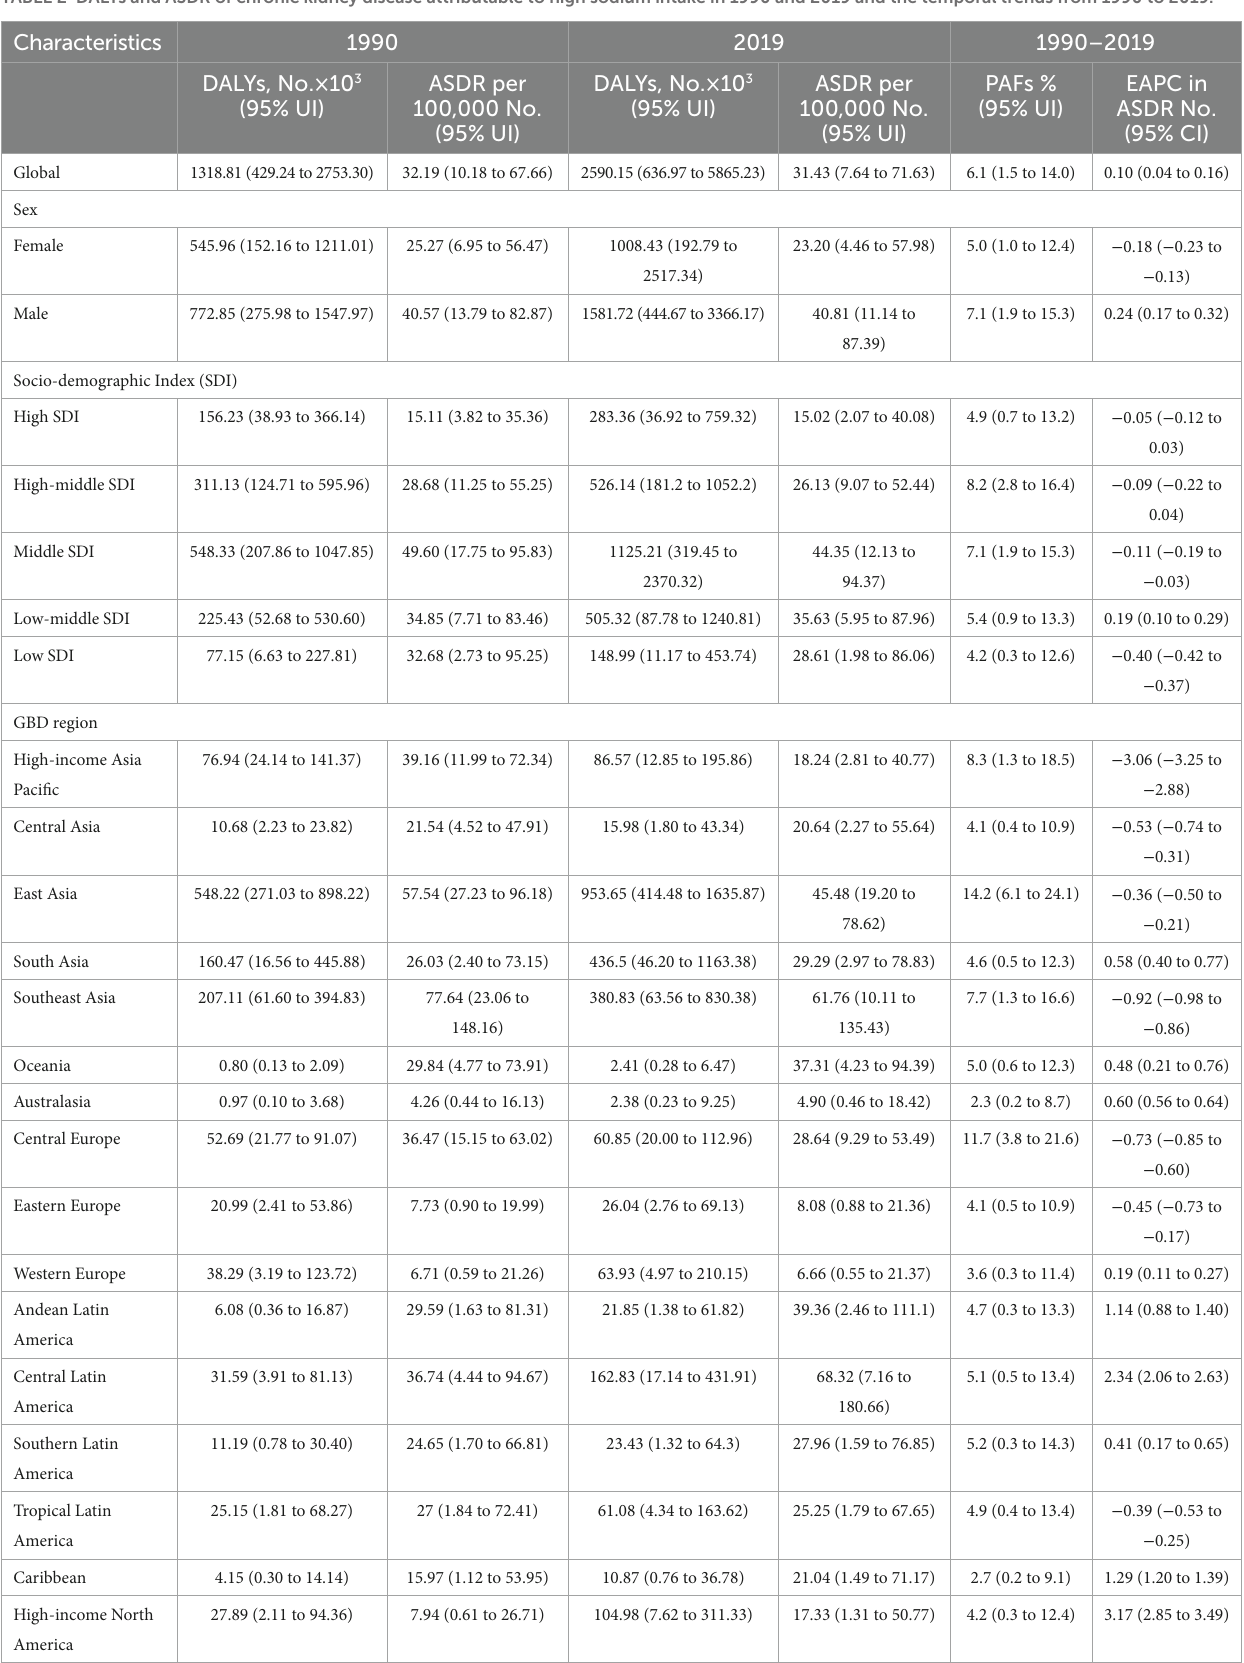
TABLE 2 DALYs and ASDR of chronic kidney disease attributable to high sodium intake in 1990 and 2019 and the temporal trends from 1990 to 2019.